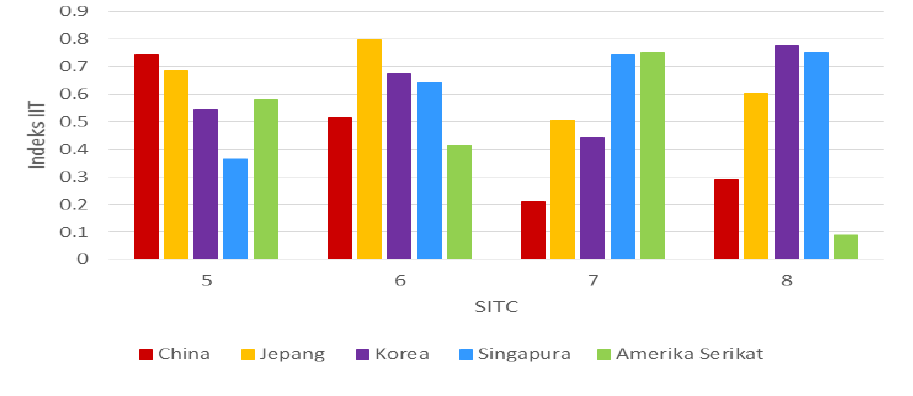
Figure 3: Average SITC 5-8 between Indonesia and Trading Partner